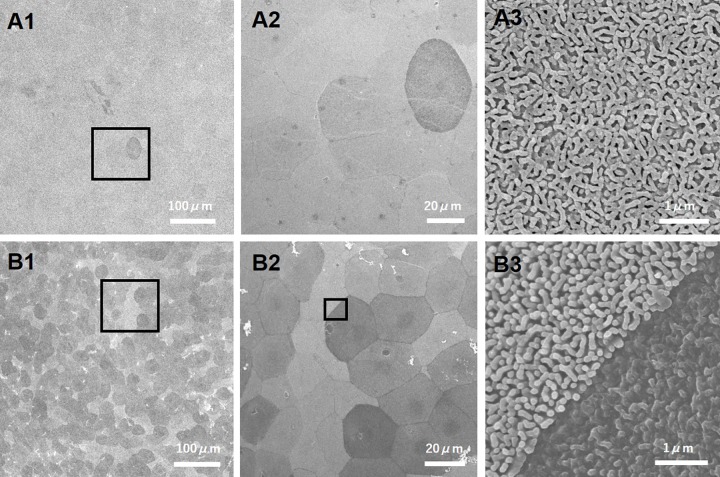
Representative SEM images of the corneal epithelium on day 30.A1-3: untreated group (A1: x100, A2: x400, A3: x15000). The undamaged corneal surface is covered with microvilli. B1-3: Latanoprost/FCTD treated group (B1: x100, B2: x400, B3: x15000). Microvilli were damaged and reduced in the dark cells. A2 and B2 are higher magnification images of the black boxes in A1 and B1, respectively. B3 shows a higher magnification image of the black box in B2.